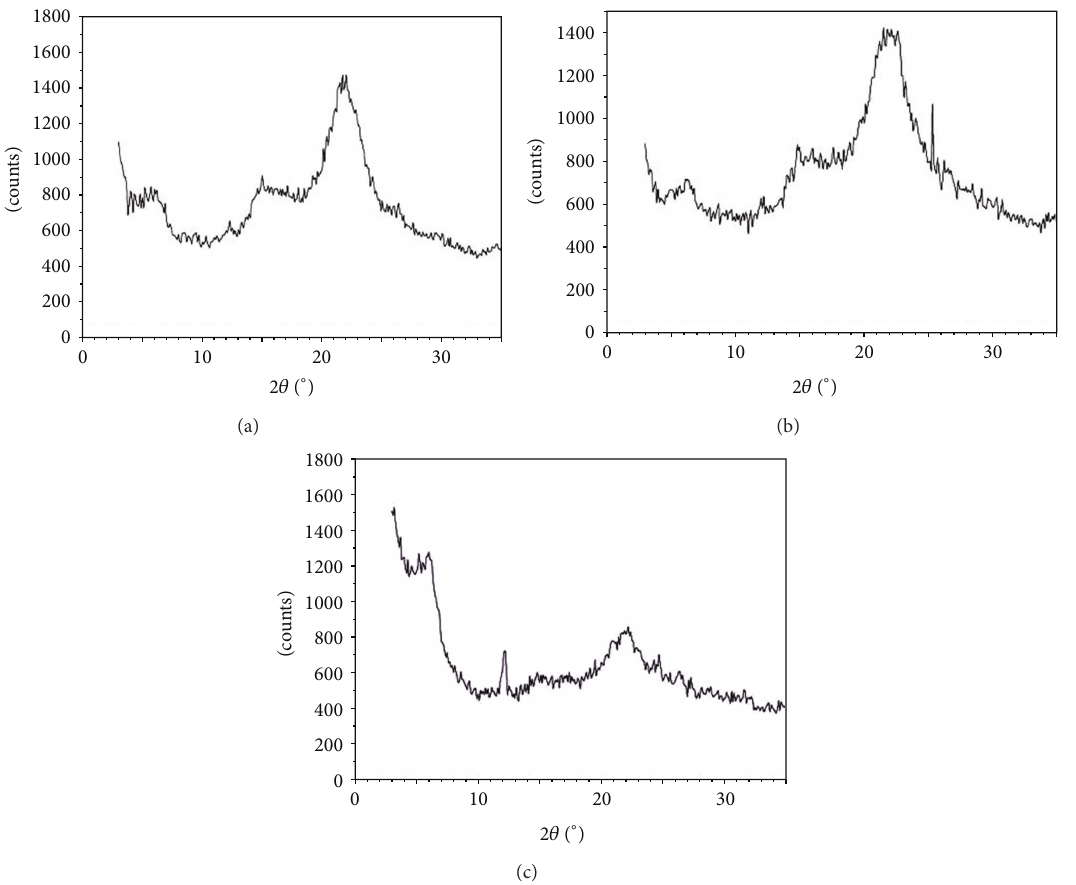
Figure 3: X-ray diffraction pattern of (a) untreated sample, (b) blank, and (c) NaOH-microwave treated